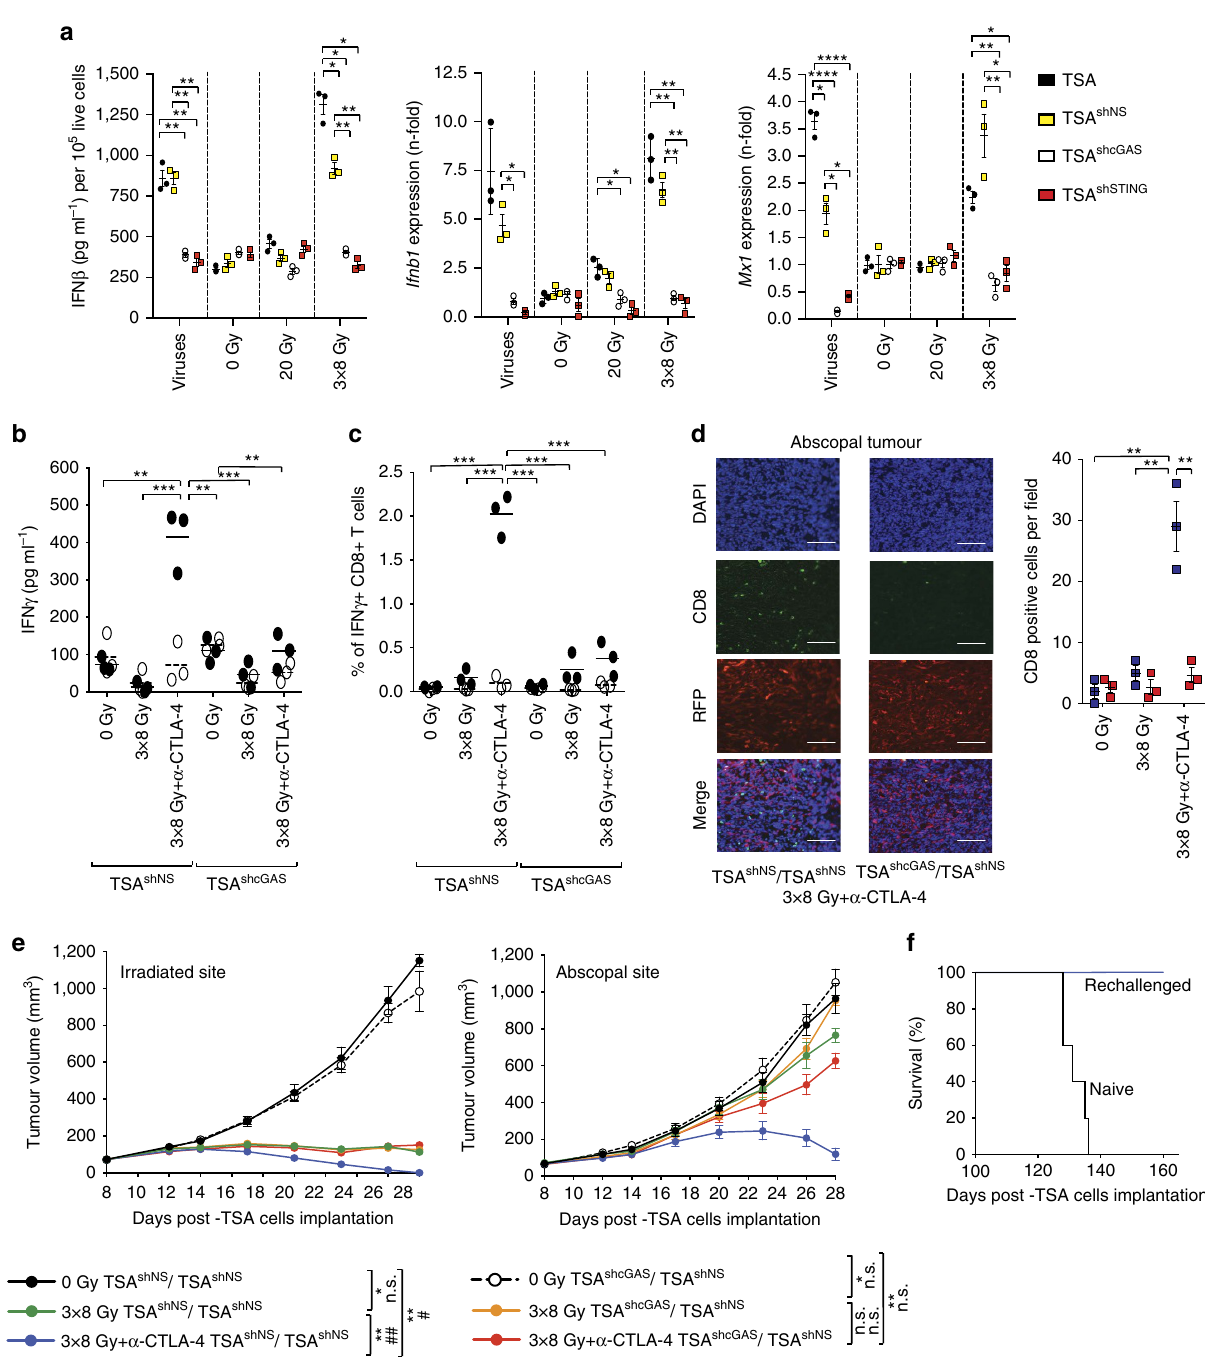
Figure 5 | Cancer cell-intrinsic type-I IFN activation is mediated by cGAS-STING pathway and is required for radiation-induced abscopal responses. ( a ) Doxycycline-inducible shRNA-mediated knockdown of cGAS (TSA shcGAS ) or STING (TSA shSTING ) in TSA cells completely abrogated IFN b release and Ifnb1 and Mx1 gene expression induced by viral infection and 8GyX3 radiation in vitro . ( b – f ) Mice with TSA shcGAS , or non-silencing shRNA (TSA shNS ) in the irradiated tumour and TSA shNS in the abscopal tumour were treated with doxycycline, 8GyX3 and anti-CTLA4. IFN g production by TDLN cells ( b ) and percentage of IFN g þ CD8 þ Tcells in spleen ( c ) in response to CD8 epitope AH1A5 (full circles) or control peptide MCMV (open circles). Each symbol represents one animal. Horizontal lines indicate the mean of antigen-specific (solid lines) or control (dashed lines). ( d ) Representative fields ( (cid:3) 200) showing CD8 þ cells (green), DAPI þ nuclei (blue), and RFP þ TSA cells (red), and mean number ± s.d. of CD8 þ cells per field in abscopal tumours harvested at day 22 from 8GyX3 þ anti-CTLA4-treated mice with irradiated TSA shcGAS (red squares) or TSA shNS (blue squares) tumours. White bars, 25um. ( e ) Growth of irradiated and abscopal tumour in mice with TSA shNS cells treated with 0Gy (black), 8GyX3 (green), 8GyX3 þ anti-CTLA4 (blue), and mice with TSA shcGAS cells treated with 0Gy (dashed line), 8GyX3 (yellow), 8GyX3 þ anti-CTLA4 (red). ( f ) Survival of mice from 8GyX3 þ anti-CTLA4 that rejected the irradiated and abscopal tumour ( n ¼ 4) and were rechallenged at day 100 with a tumorigenic inoculum of TSA cells, together with a group of naı¨ve mice ( n ¼ 5). ( a - d ) Duplicate; * P o 0.05; ** P o 0.005; *** P o 0.0005: t -test; n ¼ 3. ( e ) Duplicate; * P o 0.05; ** P o 0.005: comparison of irradiated tumour outgrowth; two-way ANOVA; n ¼ 7; ## P o 0.005: comparison of abscopal tumour outgrowth; two-way ANOVA; n ¼ 7. All data are mean ±